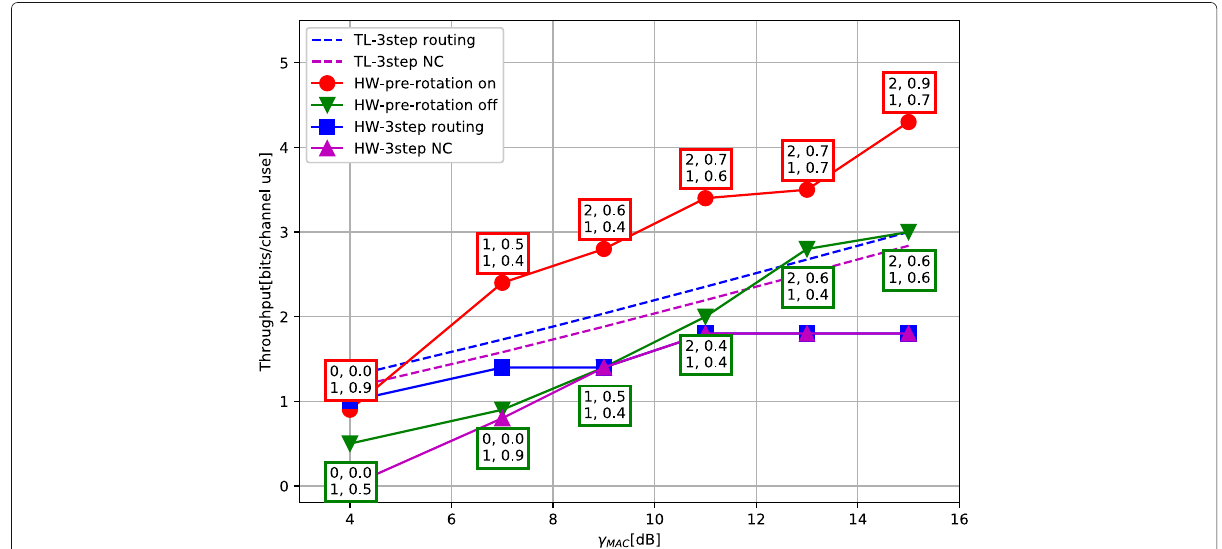
Fig. 21 Performance comparison for the setup γ BC ≈ γ MAC +5dB and γ HSI ≈ γ MAC -1dB. The numbers in boxes correspond with particular values (first row: ( N b , r b ) , second row: ( N s , r s ) ) achieving a given maximal